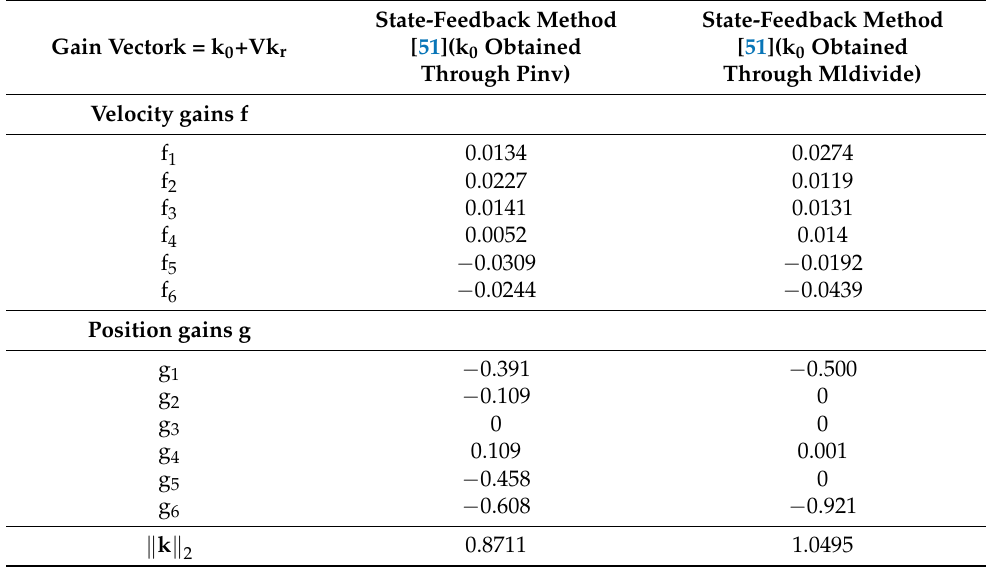
Figure 11. Open-loop and closed-loop pole-zero maps of receptance h 3,4 (j ω ) : ( a ) with the mldivide gains, ( b ) with the pinv gains. Table 10. Stabilizing control gains obtained in the second stage of the method in the numerical example of the assignment of zeros through the unit-rank active control for receptance h 3,4 (j ω ) with LMI